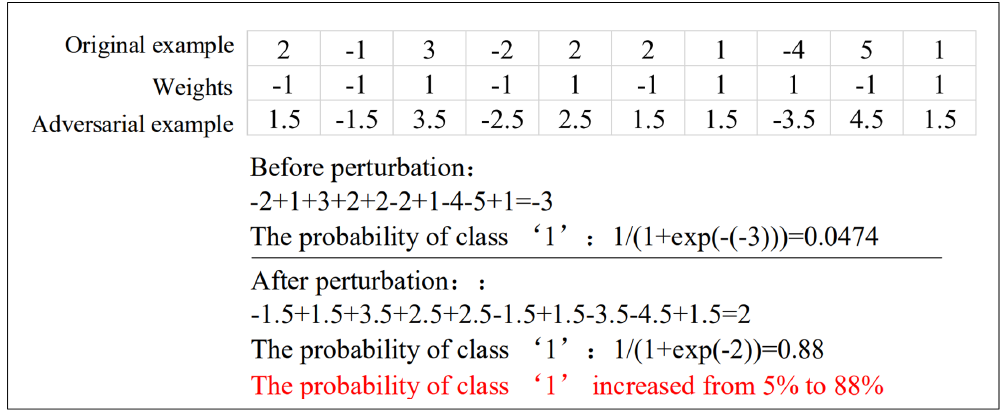
Figure 2. The probability of class “1” before and after perturbation. Before perturbating, the score of class “1” is 5%; however, the score is increased to 88% by adding or subtracting 0.5 from each dimension in a specific direction of the original sample (Image Credit: Zhang et al.